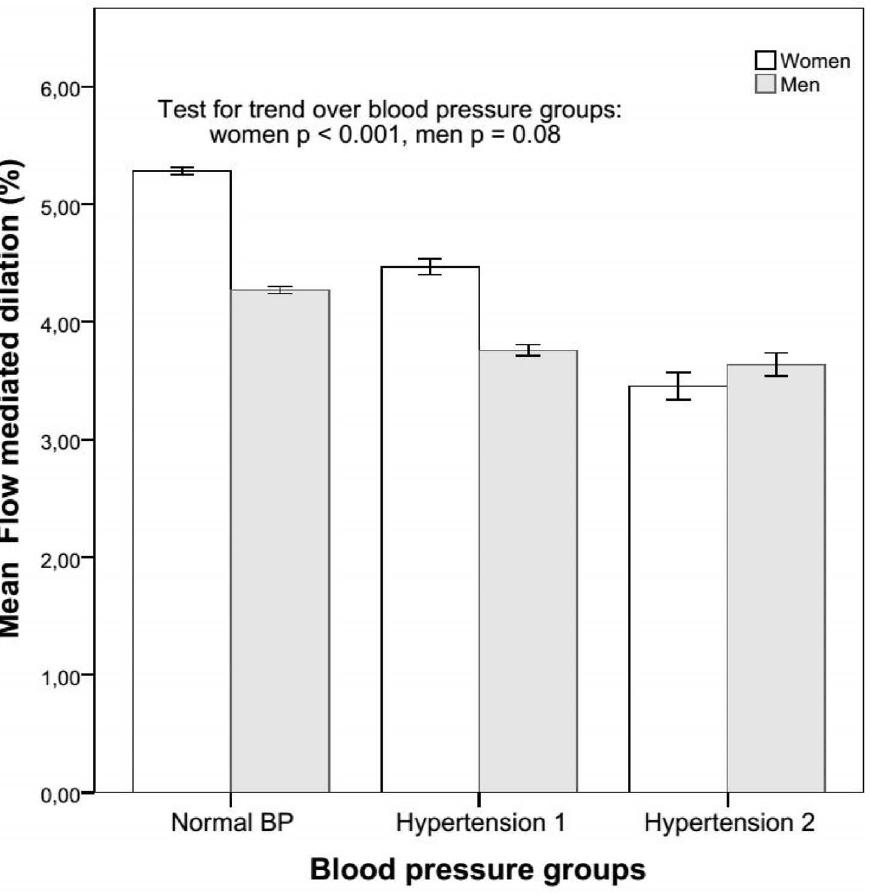
Figure 3. Flow-mediated dilation in normotension and hypertension class I and II. Mean flow-mediated dilation adjusted for age and its dependence with blood pressure groups are shown separately for women and men. Vertical lines indicate 95% confidence intervals. metabolic syndrome (Table 2, Table 3). In women with the metabolic syndrome, there was a marked difference in FMD (p , 0.001) and prevalence of ED (p =0.004) between those with hyperglycemia and those with normoglycaemia. In hypertensive women, but not in hypertensive men, FMD was reduced in subjects with concomitant hyperglycemia, compared to hyperten- sive subjects with normoglycaemia (p= 0.02, Table 4).